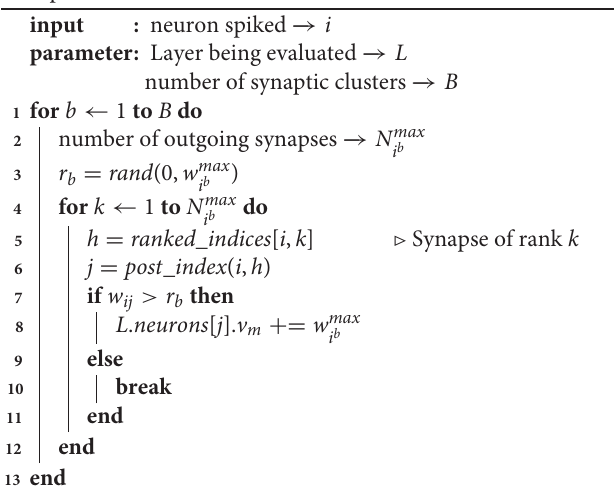
Algorithm 2: Implementation of Probabilistic Spike Prop.